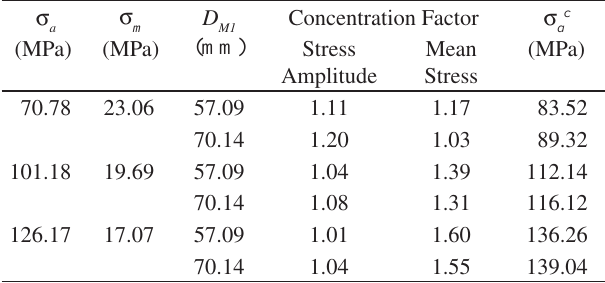
Table 4. Results of the numerical analyses.